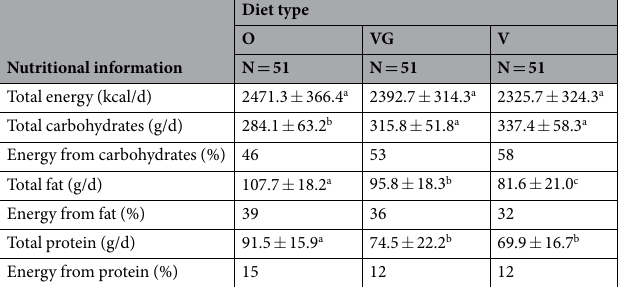
Table 3. Daily energy and nutrient intakes (as average of 7-d food record) for each of the three diet groups. Values are mean ± standard deviation of fifty-one independent measurements. Different letters indicate significantly different values ( P < 0.05) as calculated by one-way ANOVA with post hoc Tukey HSD test among the three diet groups. O, omnivores; VG, ovo-lacto-vegetarians; V, vegans.